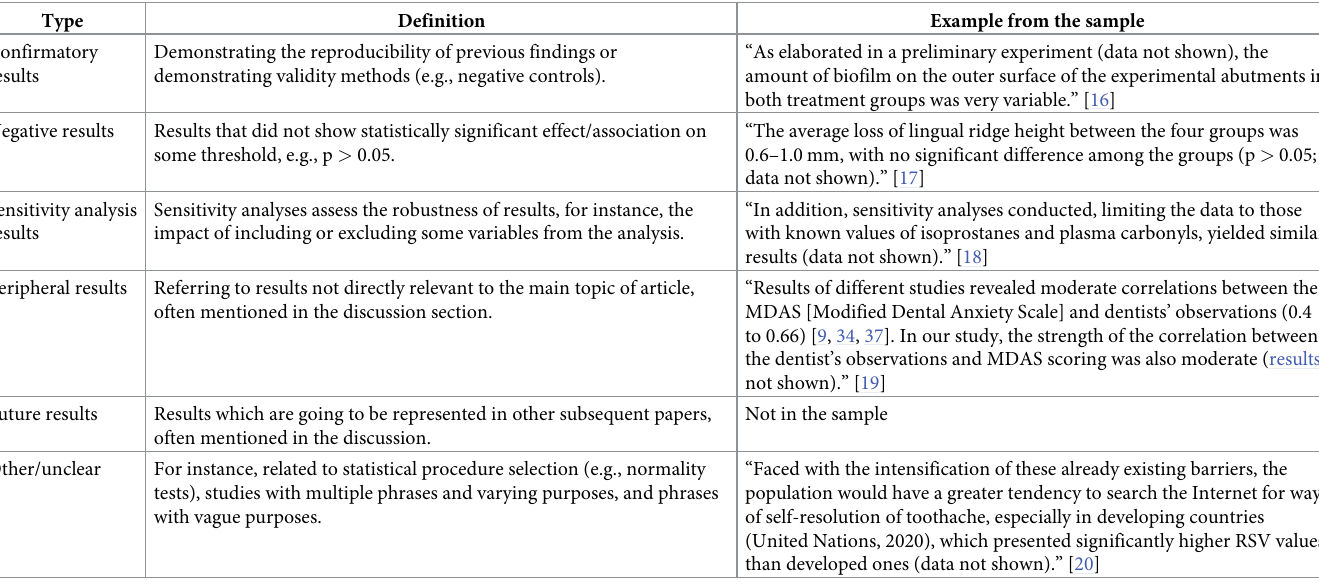
Table 1. Definitions of phrase types with examples, adapted from